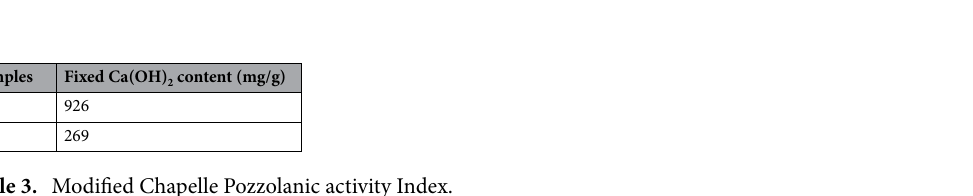
Figure 1. XRD patterns of quartz powder and silica fume.